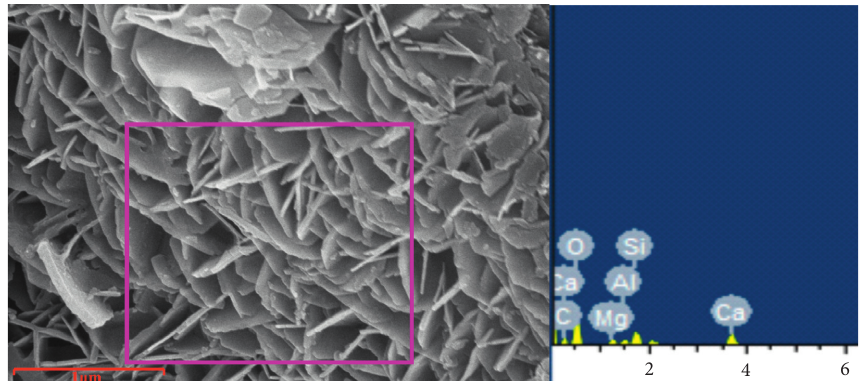
Figure 28: EDS sample diagram of Ca(OH)